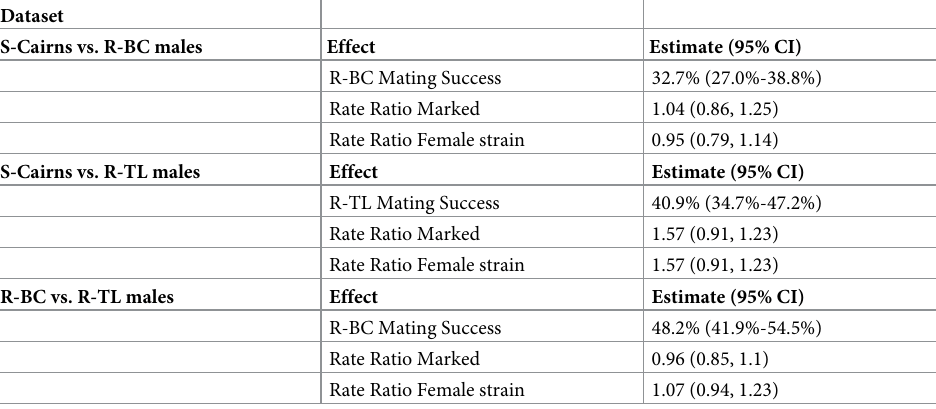
Table 1. Summary of logistic regression analysis with the log link function for analysis of mating success between males from the S-Cairns and R-BC strains, S-Cairns and R-TL strains, and R-BC and R-TL strains. The determi- nation of significance for mating success was considered as the deviation from an expected 50% mating success rate. Rate ratios for effect of Rho B staining and female mosquito strain consider a 1:1 ratio.